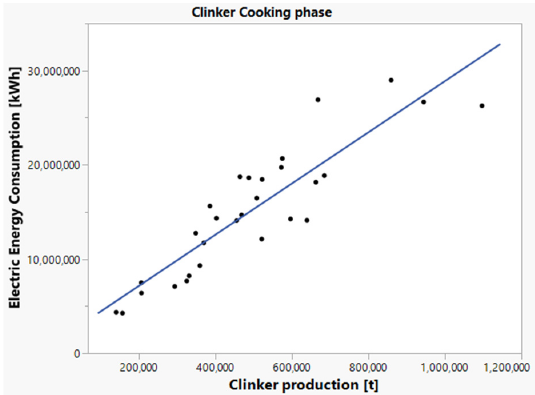
Figure 18. NACE 23.51: linear regression of electric consumption of raw material in the grinding phase (and flour homogenisation).